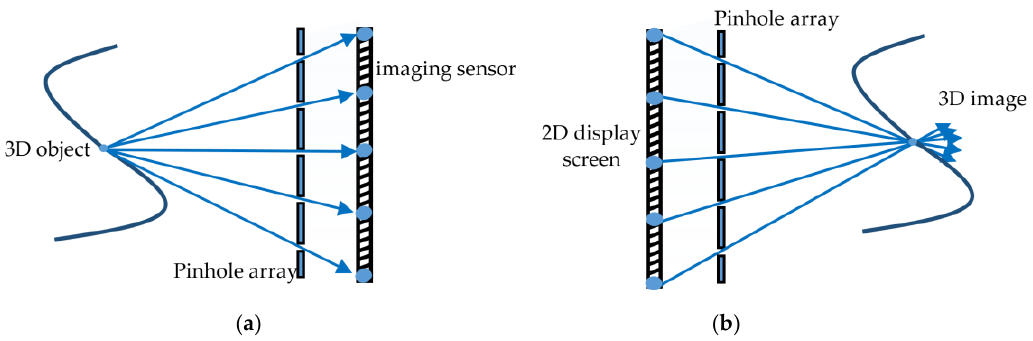
Figure 1. ( a ) Pickup process and ( b ) display process of the pinhole array-based II.